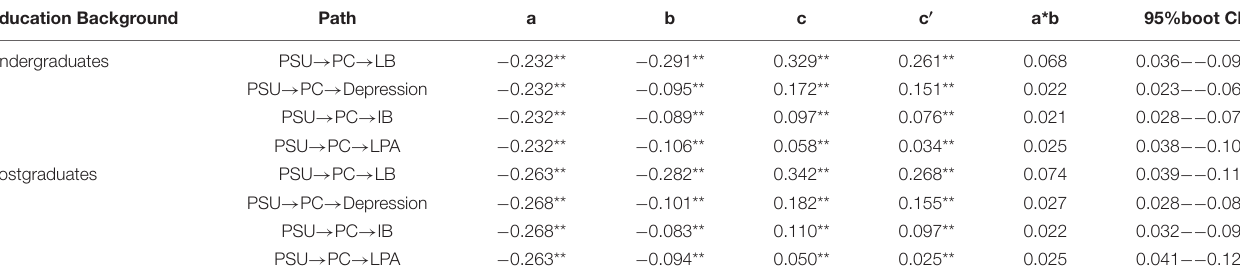
TABLE 5 | The significance of the mediating effect of psychological